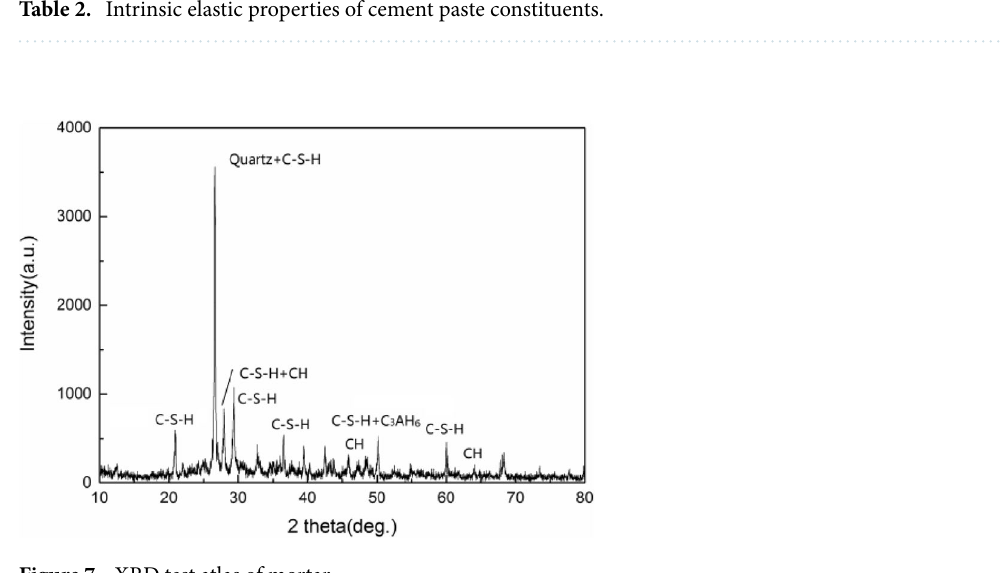
Figure 7. XRD test atlas of